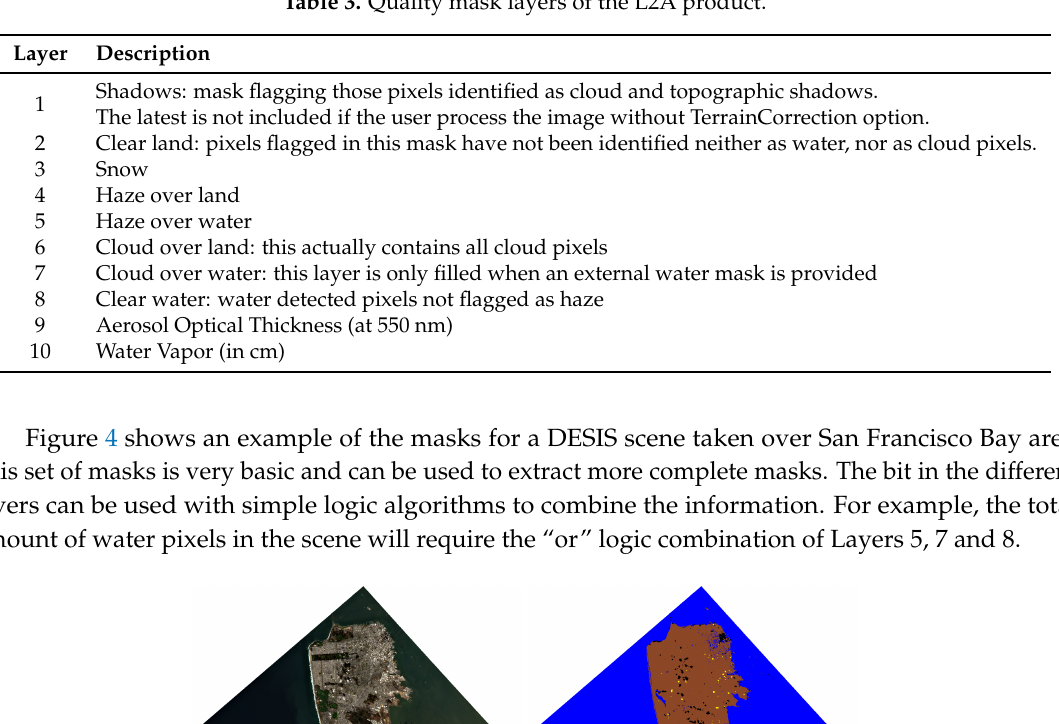
Table 3. Quality mask layers of the L2A product.